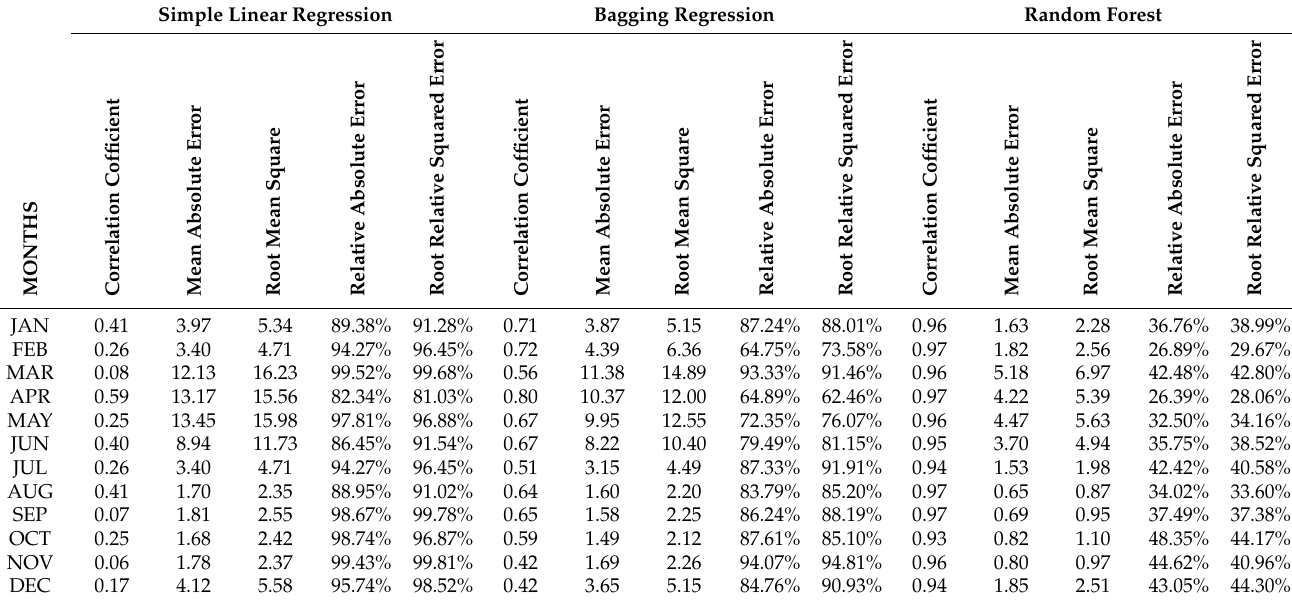
Table 3. Calculated error values of algorithms used for machine